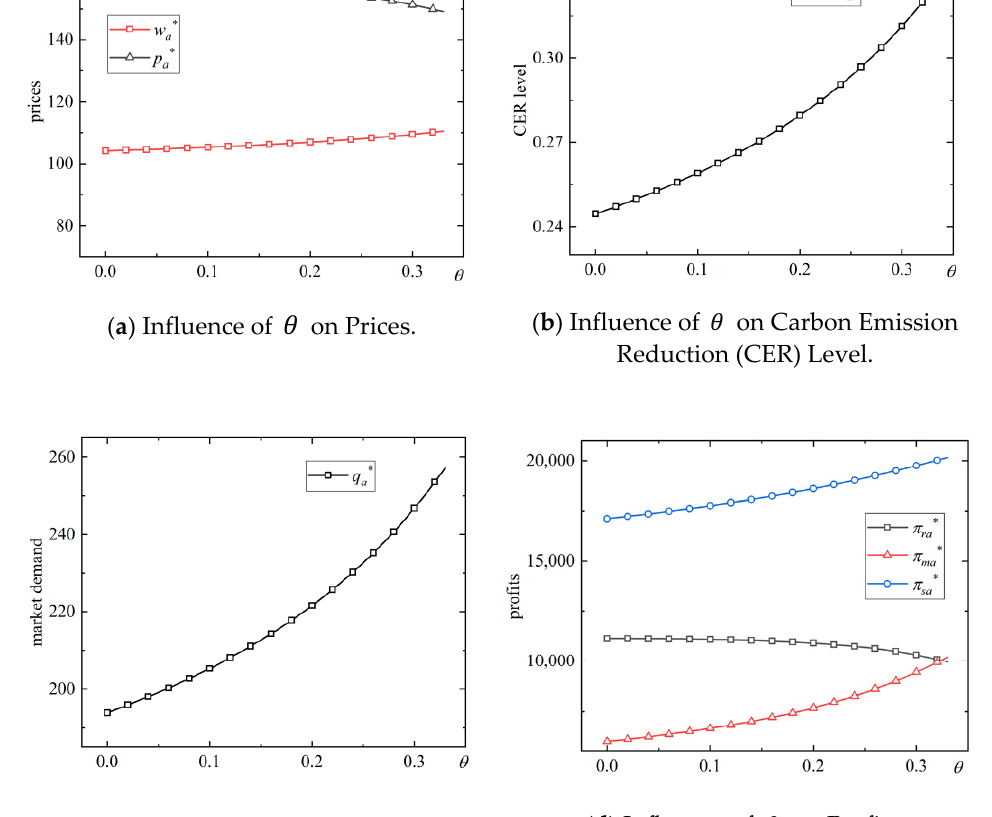
Figure 1. The Influence of Altruistic Preference 𝜃 on Supply Chain Decision.